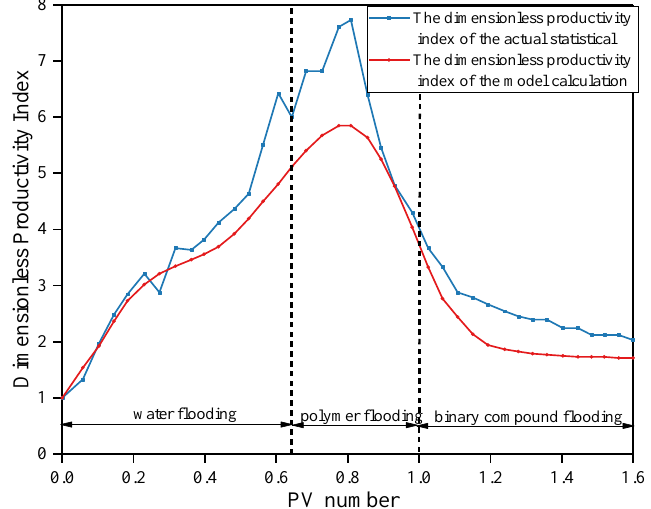
Figure 3. Comparison of the change in the dimensionless productivity index of the actual statistics and the new calculation model with the pore volume ( PV) number injected.